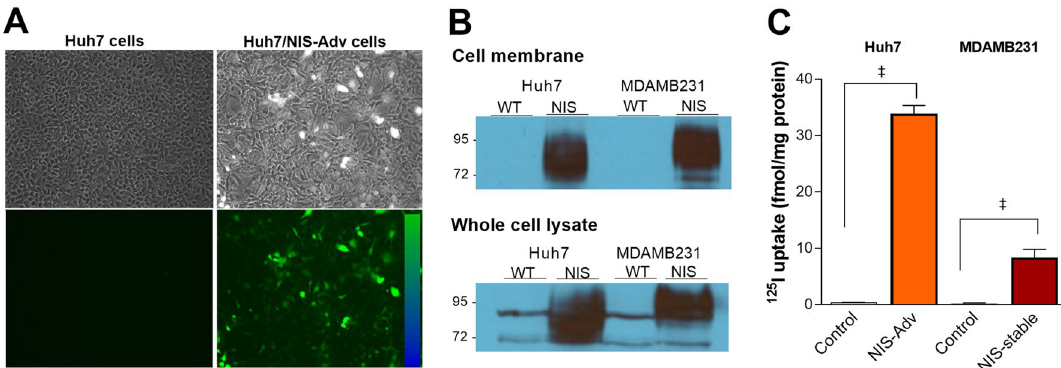
Figure 1. EGFP and NIS proteins in transiently and stably expressing cancer cells. ( A ) EGFP fluorescence in Huh7 cells transduced with NIS/EGFP adenovirus (Huh7/NIS-Adv cells). ( B ) Western blots of NIS protein obtained from the cell membrane fraction (top) and whole cell lysates (bottom) of Huh7, Huh7/NIS-Adv, MDAMB231, and MDAMB/NIS-stable cancer cells. ( C ) 125 I uptake (right) in Huh7/NIS-Adv and MDAMB/ NIS-stable cells compared to respective Huh7 and MDAMB control cells. Bars for uptake are mean ± SD of uptake in fmol/mg protein obtained from triplicate samples per group. WT wild type. ‡ P <